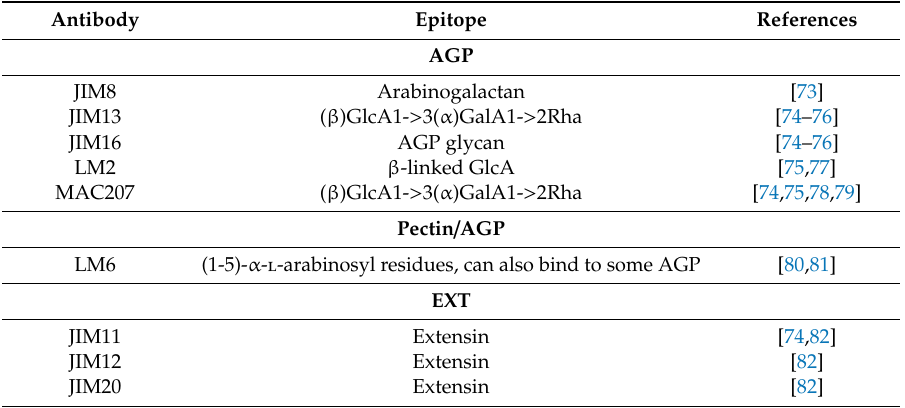
Table 1. The antibodies that were used for the immunocytochemistry, the epitopes they recognise and the relevant